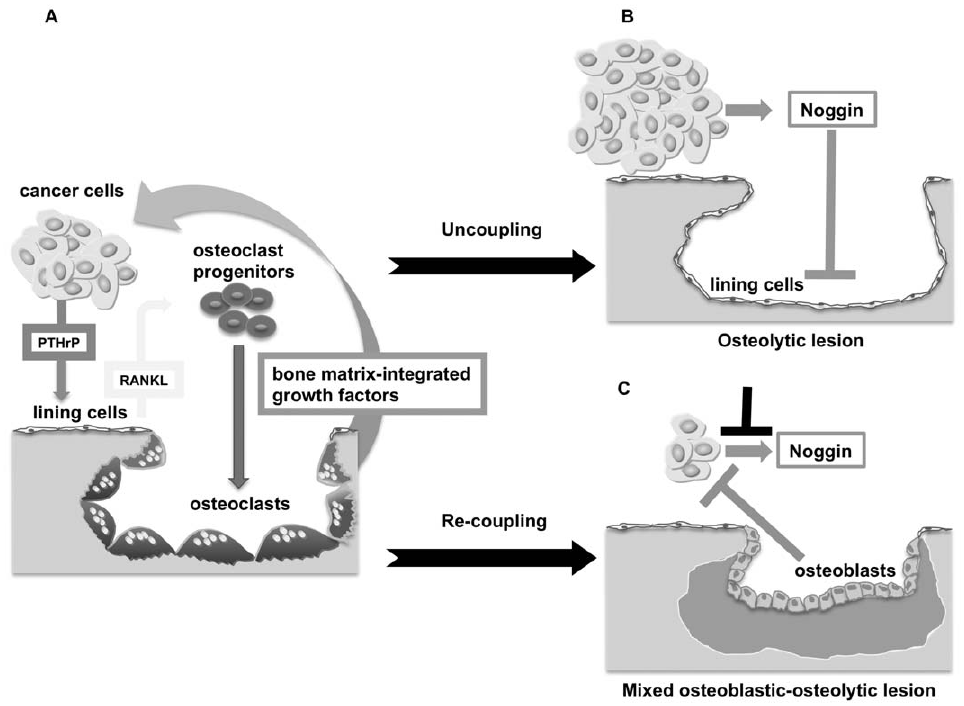
Figure 7. Model of osteolysis integrating a dual mechanism of stimulated bone resorption and ‘‘uncoupled’’ bone formation. The osteolytic lesion is the net result of two different mechanisms leading to uncoupling of normal bone remodeling: A . Excess of bone resorption, consequent to enhanced osteoclast recruitment and activity induced by cancer cell-derived osteolytic cytokines. The subsequent release of bone matrix-integrated growth factors further stimulates cancer cell growth. B . Suppression of bone formation, consequent to interference with osteoblast recruitment and activity induced by cancer cell-derived noggin. C . Noggin silencing in cancer cells re-establishes osteoblast recruitment and activity, and, thus, ‘‘bone coupling’’, with consequent bone formation/repair. As an effect of the rescued osteoblast activity, tumor progression is contained by yet unidentified osteoblast-derived factors.